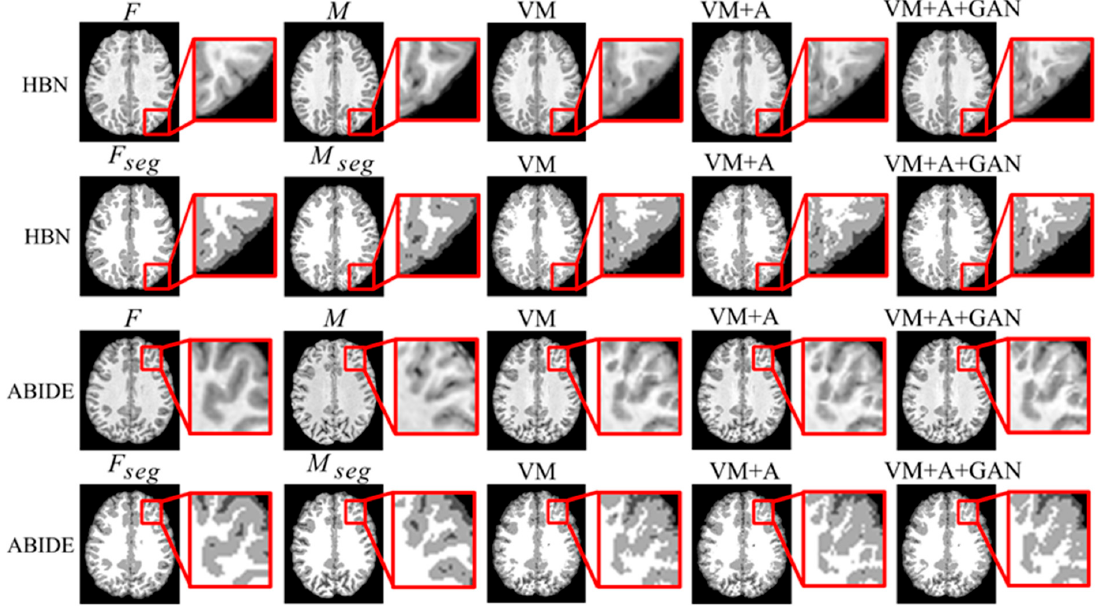
Figure 4. Registration results based on deep learning methods. Among them, VM represents the result obtained by the VoxelMorph method, VM + A represents the result obtained by training the registration network and the enhanced network together, and VM + A + GAN represents the result obtained by our method.